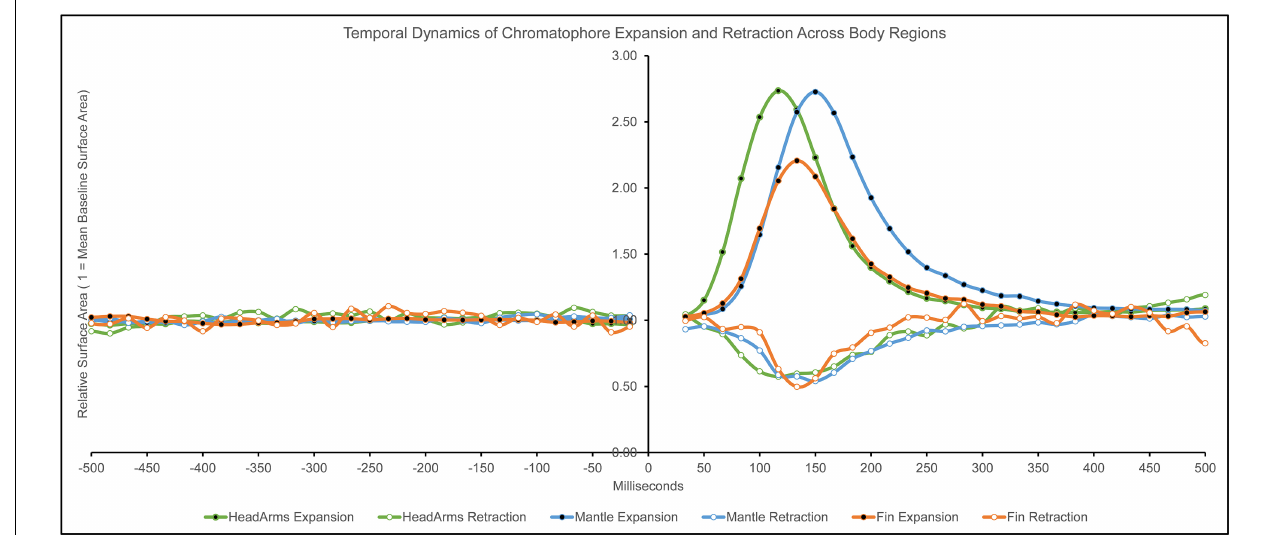
FIGURE 3 | Temporal dynamics (in milliseconds) of chromatophore expansion and retraction across body regions. Surface area values are relative to the average pre-flash chromatophore surface area (1 = average of pre-flash chromatophore surface area; values above 1 = expansion, values below 1 = retraction). Negative values of milliseconds indicate time before the light flash presentation, 0 indicates flash presentation, positive values indicate time after the light flash presentation (The two frames containing the flash stimulus, t = 0 ms and t = 17 ms, were removed from analysis due to the animal not being observable).